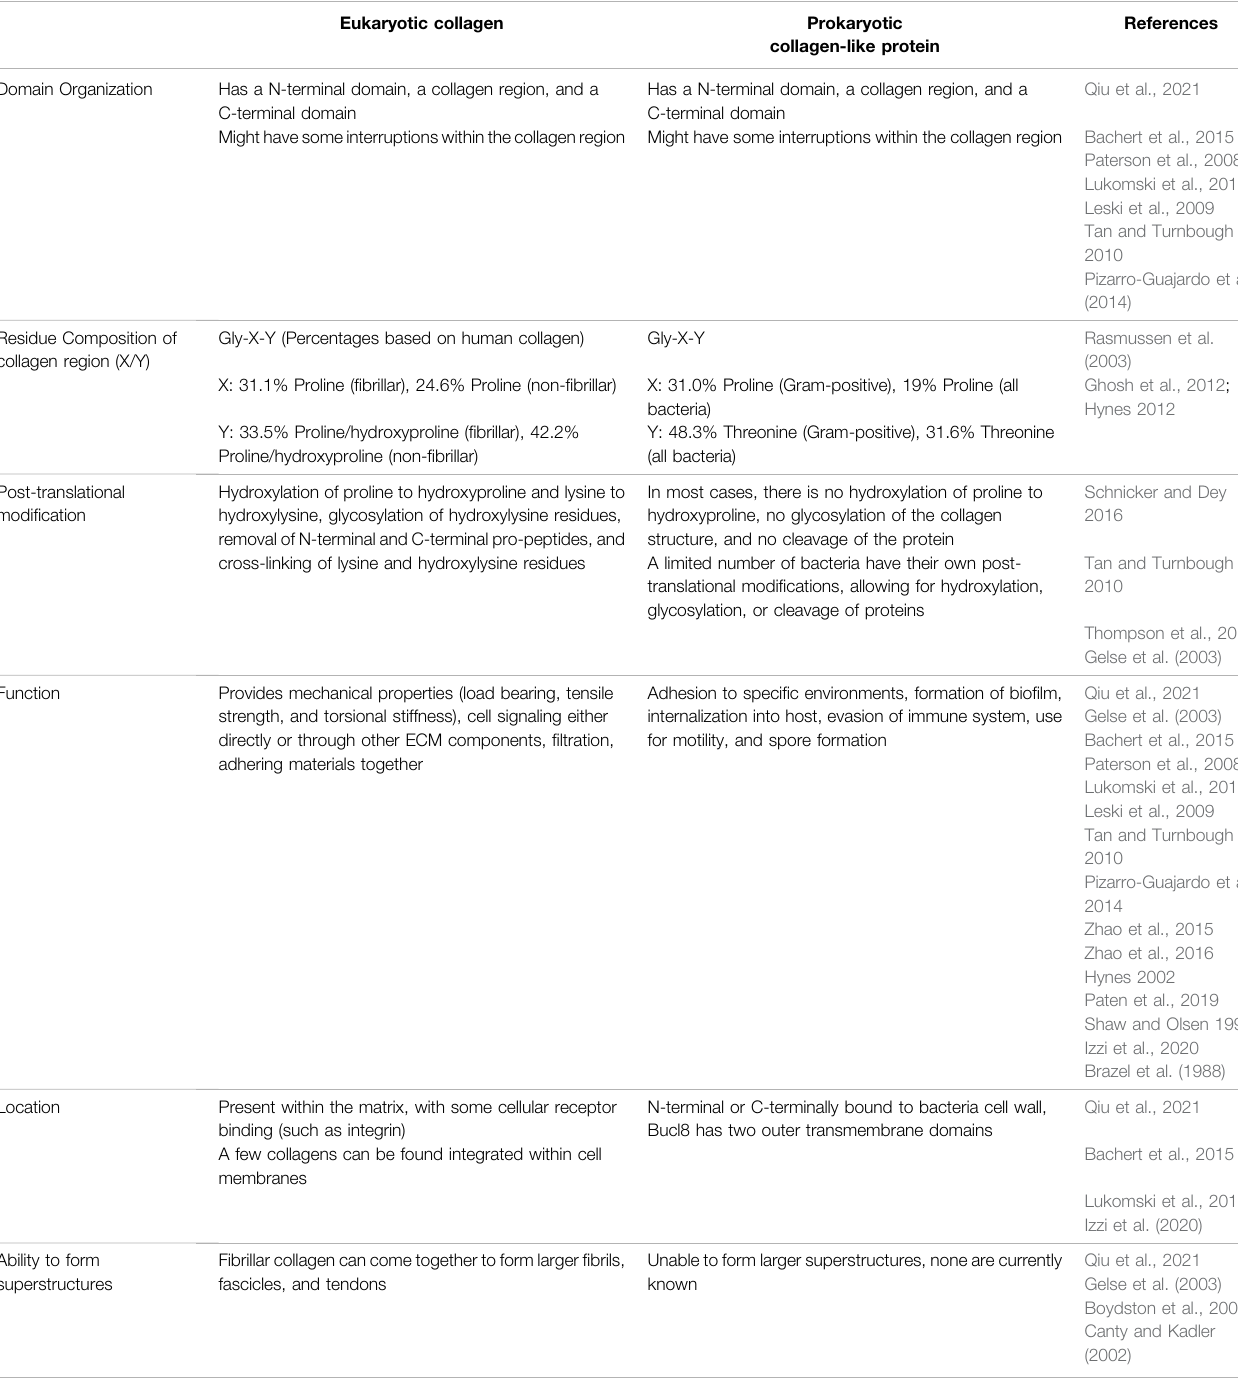
TABLE 1 | Characteristics of eukaryotic collagens and prokaryotic collagen-like proteins. Eukaryotic collagen Prokaryotic collagen-like